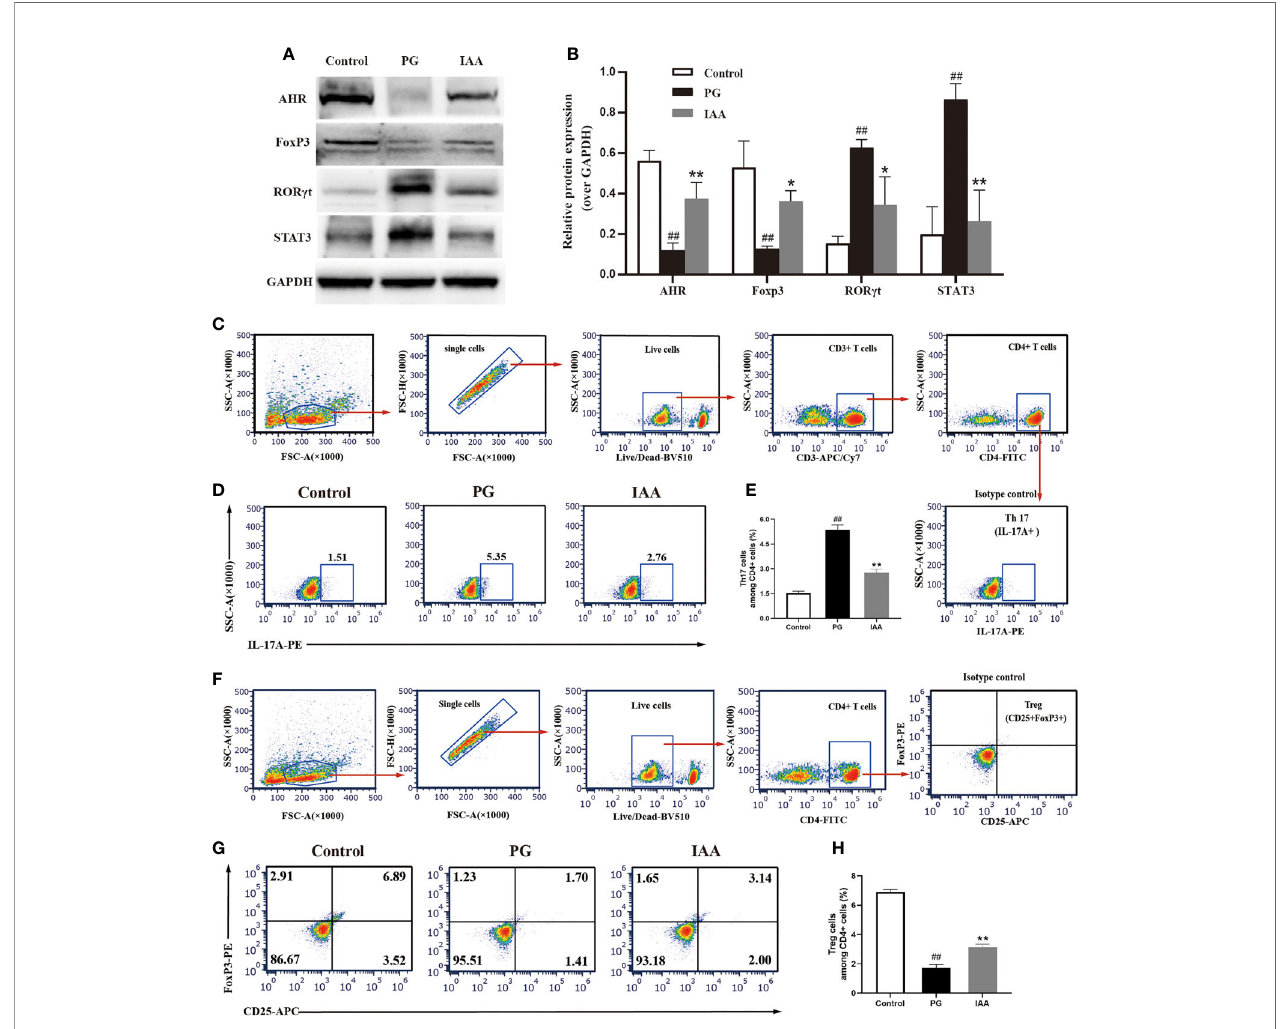
FIGURE 4 | IAA activates AhR signaling pathway and restores Th17/Treg balance in AS mice. (A) The protein levels of aryl hydrocarbon receptor (AhR) and Th17/Treg- related transcription factors, such as forkhead box protein P3 (FoxP3), signal transducer and activator of transcription 3 (STAT3), and retinoic acid receptor – related orphan receptor gamma (ROR g t) in ileum tissue from three groups of mice were analyzed by western blot analysis, as shown in representative blots from one of three independent experiments. (B) Relative protein expression of AhR, FoxP3, STAT3, and ROR g t using densitometric analysis, with glyceraldehyde 3-phosphate dehydrogenase (GAPDH) as a loading control (n=3). (C-H) Flow cytometric analysis of the frequencies of Th17 and Treg cells in ileum lamina propria from three groups of mice. (C) Gating strategy used for analysis of Th17 cells. Arrows indicate that Th17 cells were sequentially gated from single cells, live cells, CD3 + cells and CD4 + cells. Gated CD4 + cells were analyzed for expression of IL-17A. Representative plots of IL-17A expression (D) and percentage of IL-17A + cells (E) among CD4 + T cells (n=6). (F) Gating strategy used for analysis of Treg cells. Arrows indicate that Treg cells were sequentially gated from single cells, live cells, and CD4 + cells. Gated CD4 + cells were analyzed for expression of CD25 and Foxp3. Representative plots of CD25 and Foxp3 expression (G) and percentage of CD25+Foxp3 + T cells (H) among CD4+ T cells (n = 6). Data are expressed as the mean ± standard deviation (SD); ## p < 0.01 vs. control; * p < 0.05, ** p < 0.01 vs. PG alone. IAA, indole-3 acetic acid; Th17, T-helper 17; Treg, T regulatory; AS, ankylosing